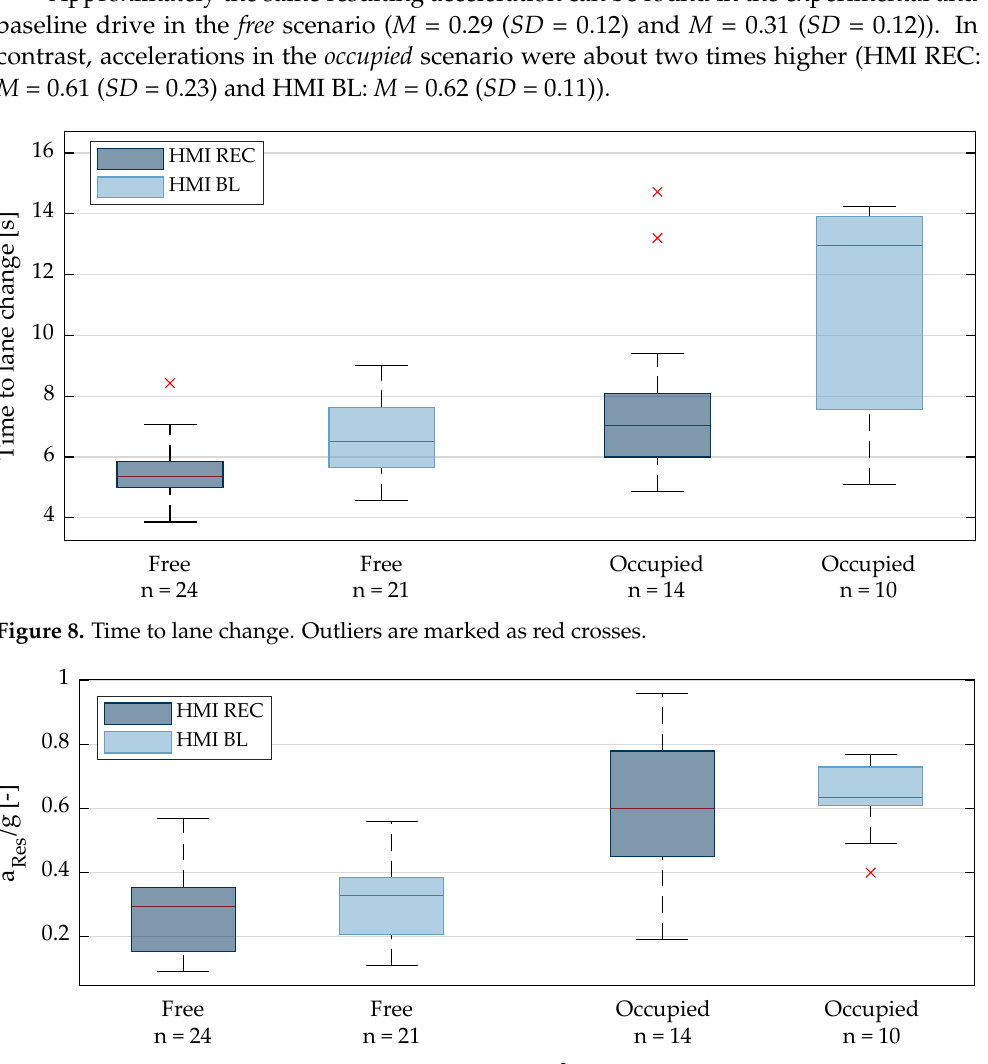
Figure 9. Resulting acceleration as portion of g (9.81 m/s 2 ). Outliers are marked as red